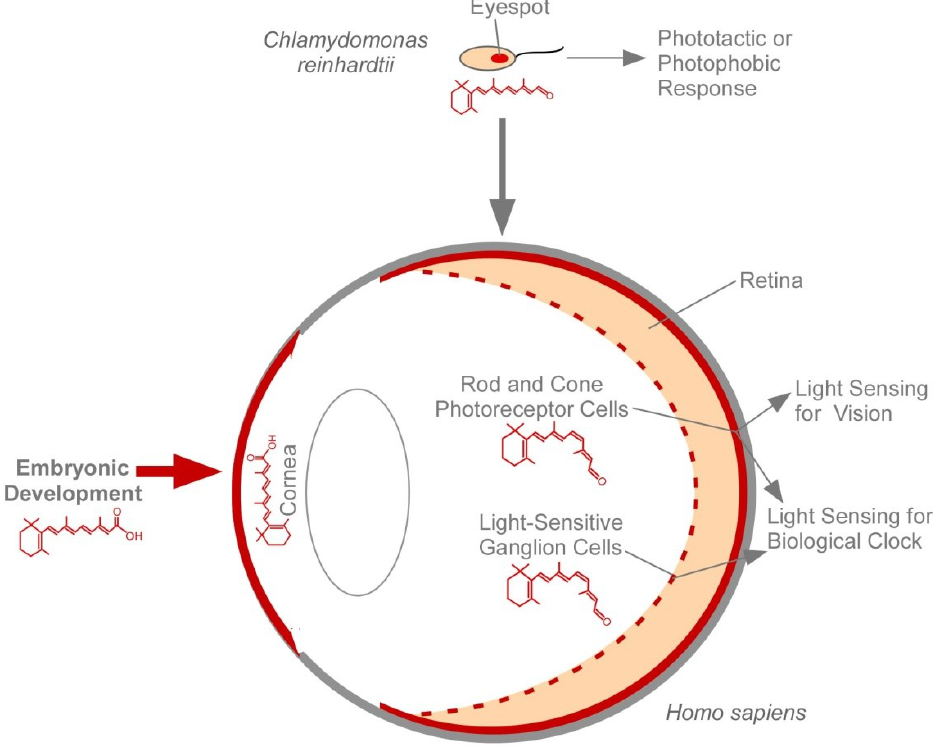
Figure 4. Comparison of two retinal-based light sensing structures: the eyespot in Chlamydomonas reinhardtii and the human eye. The human eye depends on vitamin A not only for light sensing for vision and the biological clock, but also for embryonic development and for the maintenance of the cornea. Cells or structures that depend on vitamin A are labeled in red.